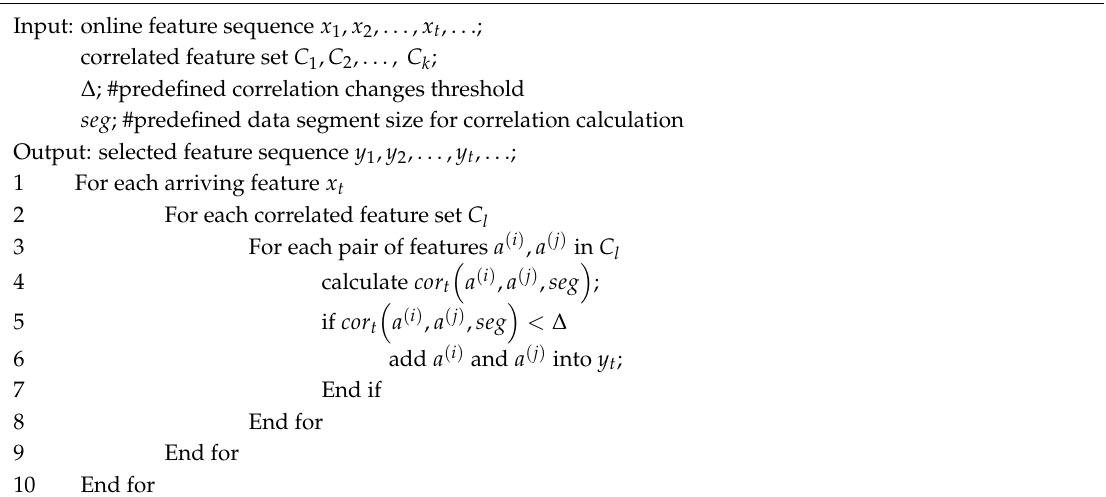
Algorithm 1. A simple algorithm for online feature